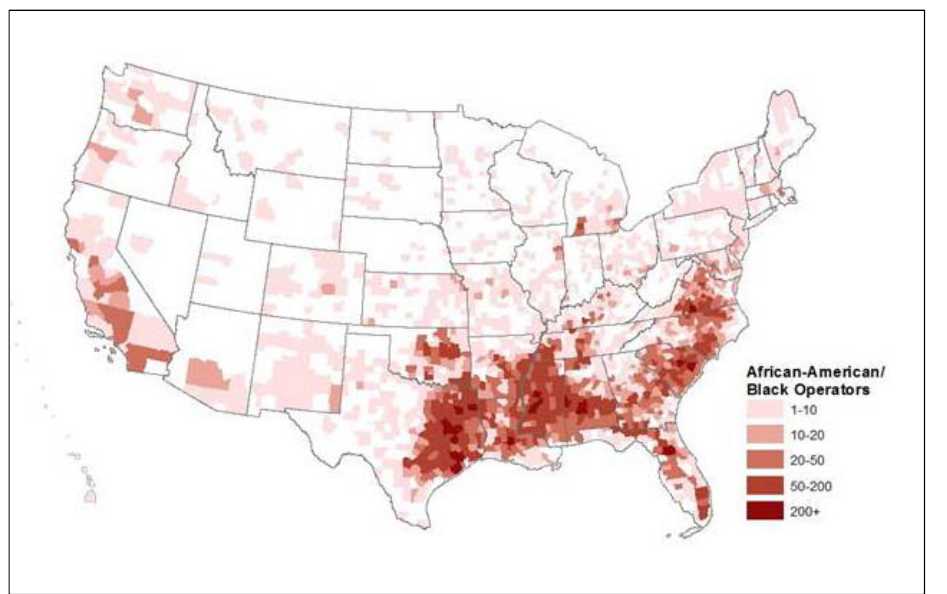
Figure 6. Spatial Distribution of African American Farmers,